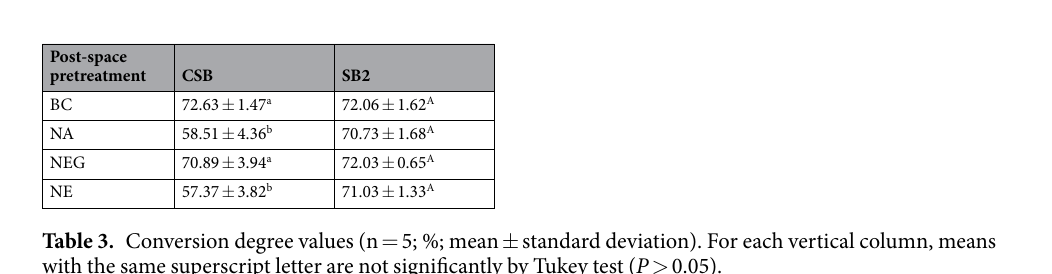
Figure 3. Representative micro-Raman spectrum of mineralized dentine. At 960 cm − 1 , the peak is associated with the mineral PO 43 − group is clearly visible (finger).